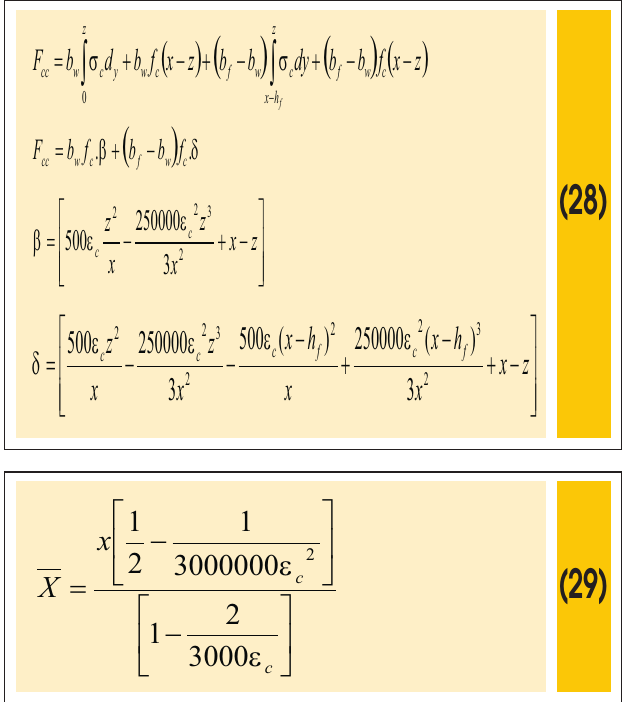
lower or equal to 0,002. The equations that have components of represented in equations 26 and 27,